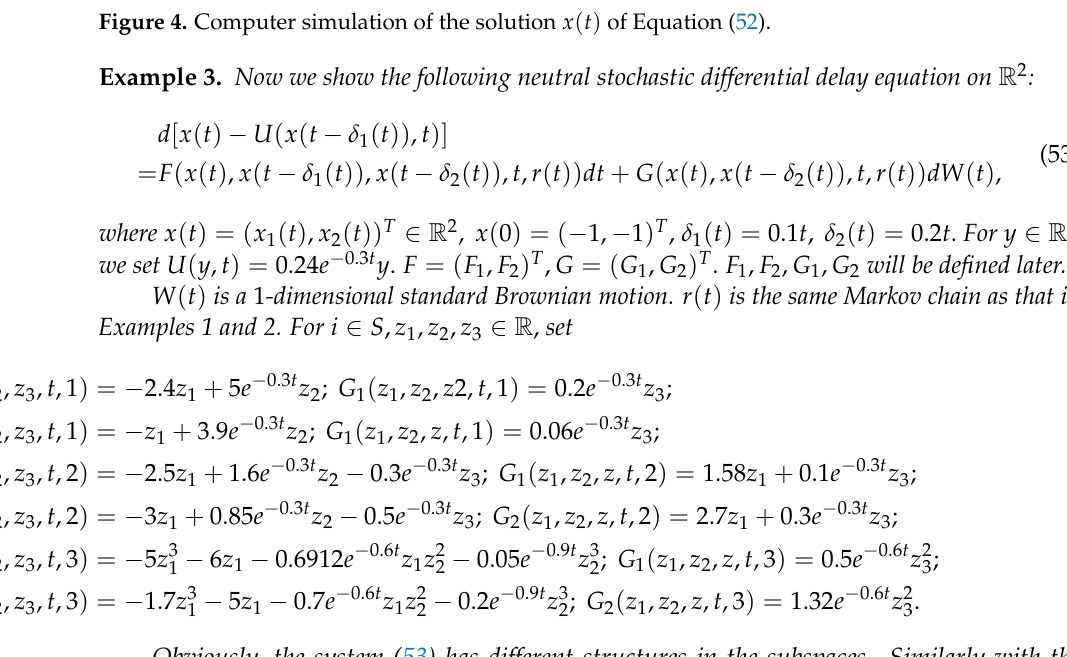
Figure 4. Computer simulation of the solution x ( t ) of Equation